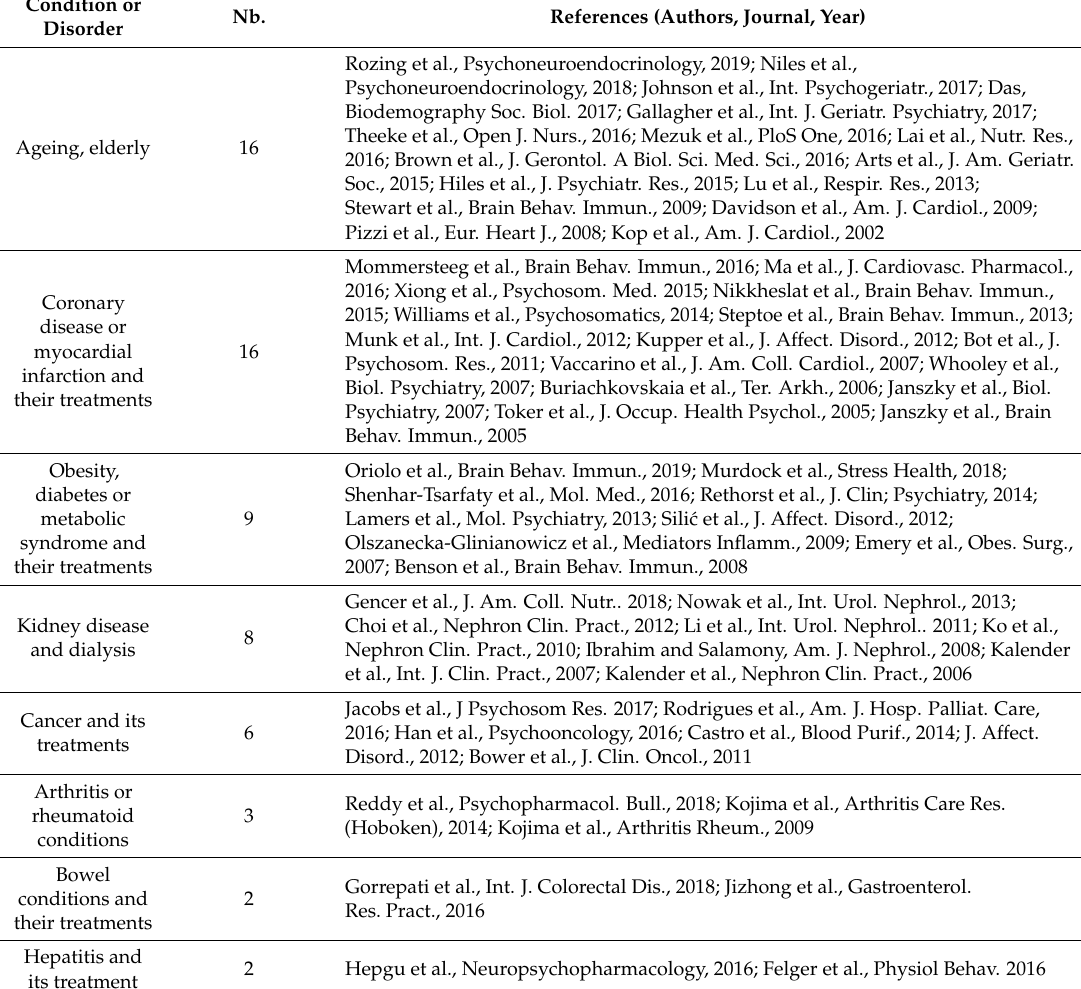
Table based on Pubmed search using the string (inflammation [TI] AND depression [TI]) NOT review NOT comment NOT “spreading depression” NOT (animal OR rat OR mouse) on 31/01/19. Nine-teen articles were excluded from the 153 obtained, 17 because articles did not report original findings and 2 because the term depression was used in a different context. The remaining 134